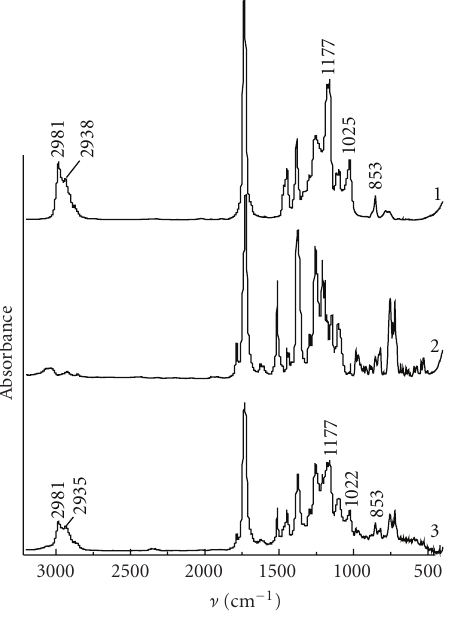
Figure 6: FTIR spectra of PEA (1), PI 2 (2), and PEA obtained in the presence 42 wt% of PI 2 and precipitated into methanol (3).